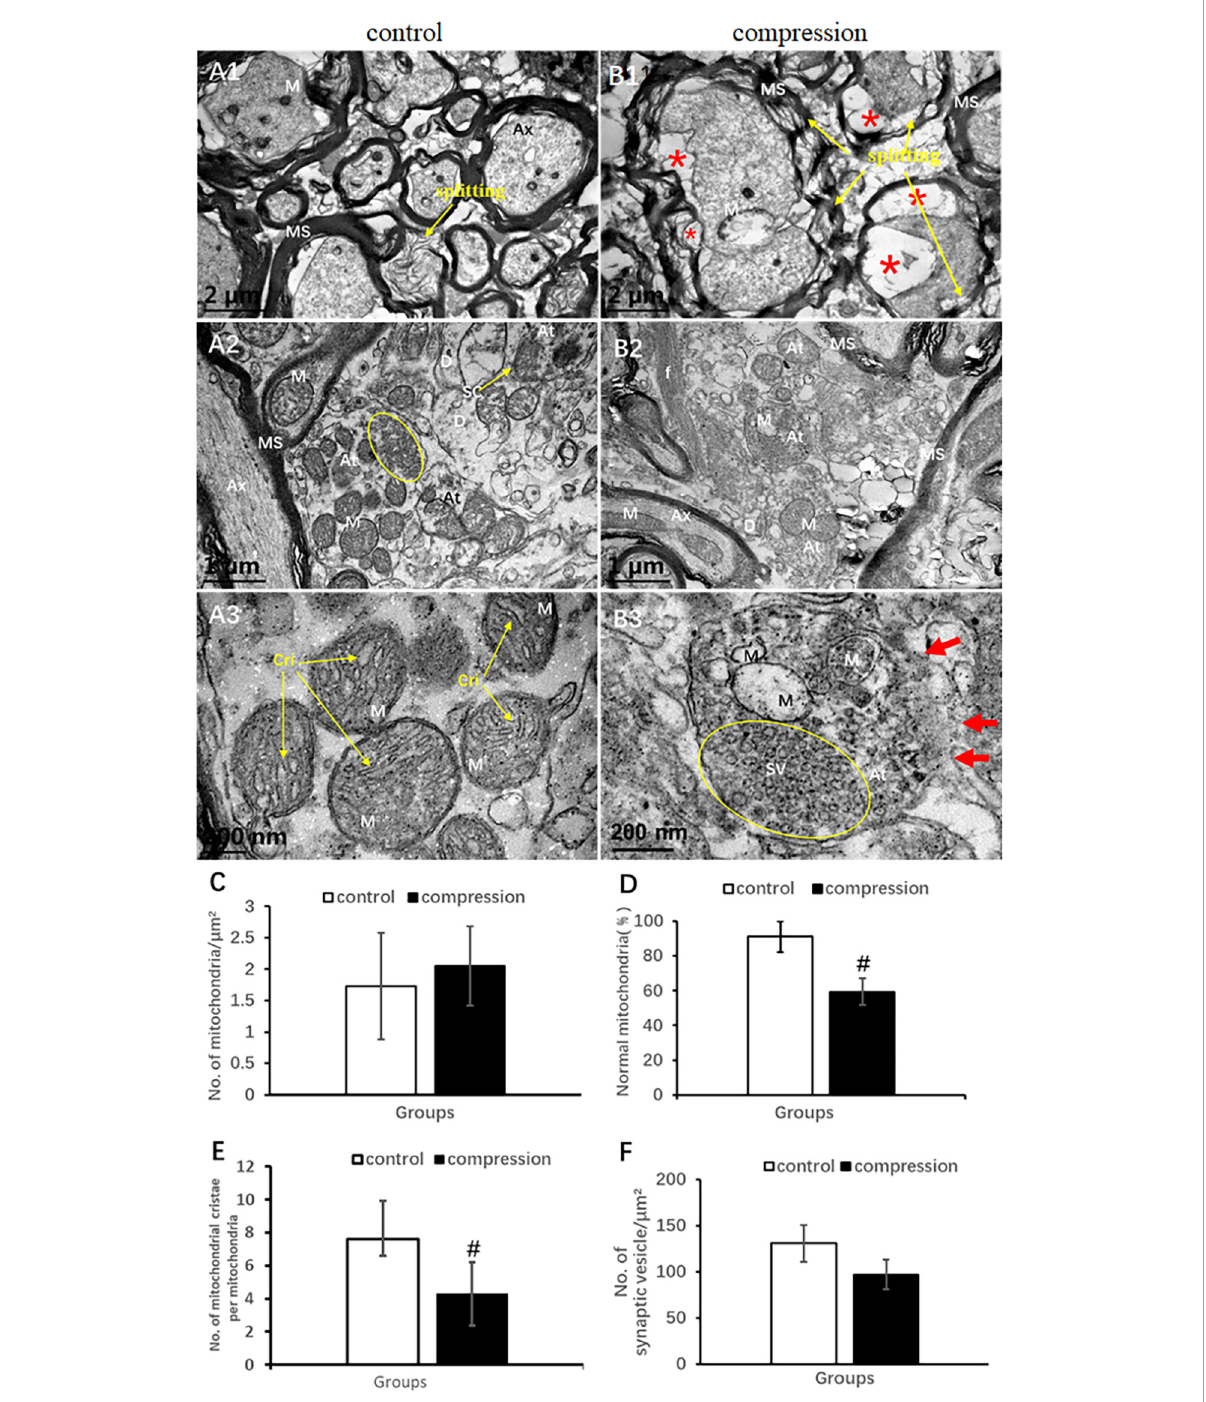
FIGURE6 Comparison of ultrastructural destruction of axon and axonal terminal between samples from the control group (A1–A3) and CSM group (B1–B3) . Increased total number of mitochondria (C) but significantly decreased number of mitochondria with normal appearance (D) and mitochondrial cristae (E) in the CSM group. (F) No significant decrease in the number of synaptic vesicles after compression. Ax, axon; MS, myelin sheath; f, filament; At, axonal terminal; SC, synaptic cleft; SV, synaptic vesicle; D, dendrites; M, mitochondria; Cri, mitochondrial cristate; yellow oval include synaptic vesicle “*” axonal cavitation; “#” significant difference between compression and control group ( P < 0.05, n = 6